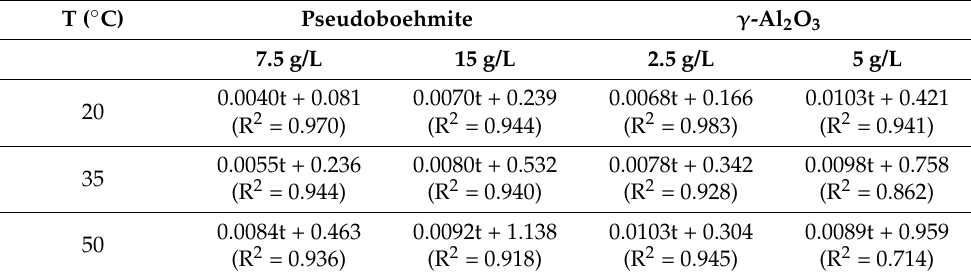
Table 6. Boyd fit results for pseudoboehmite and γ -Al 2 O 3 .